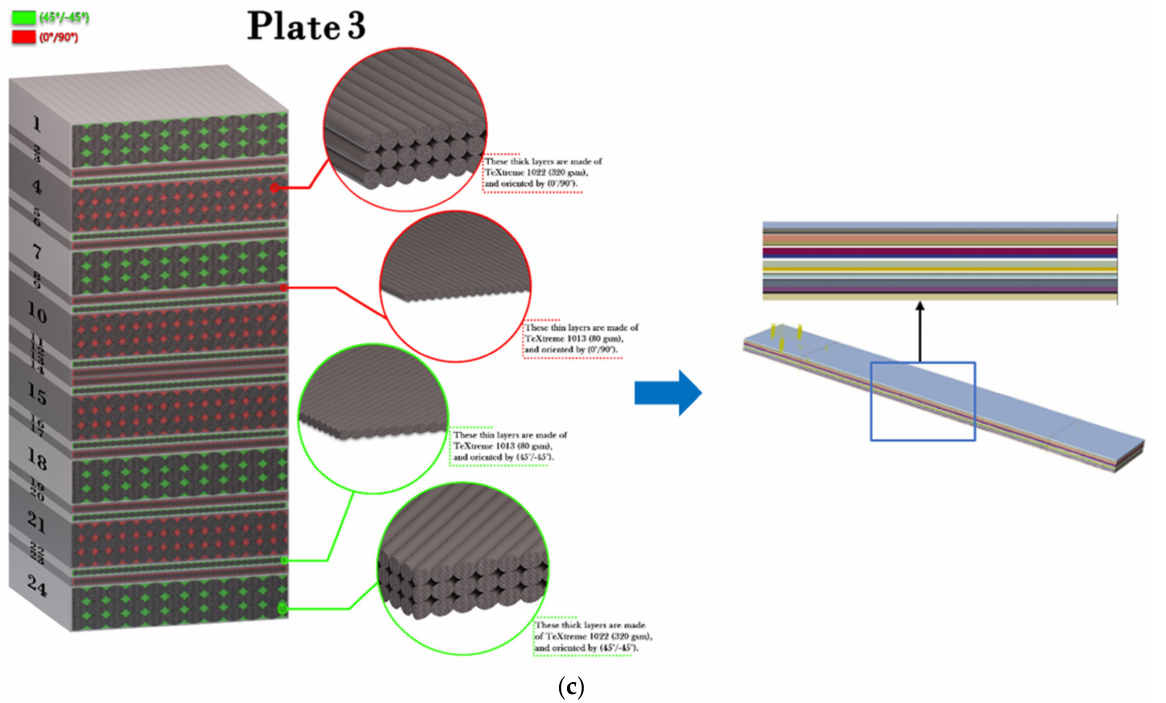
Figure 1. Cross-sections of the three different groups of samples and their stacking schemes; ( a ) baseline (reference) laminate of traditional plies and its model, ( b ) hybrid (standard and thin plies) laminate A and its model, ( c ) hybrid (standard and thin plies) laminate B and its